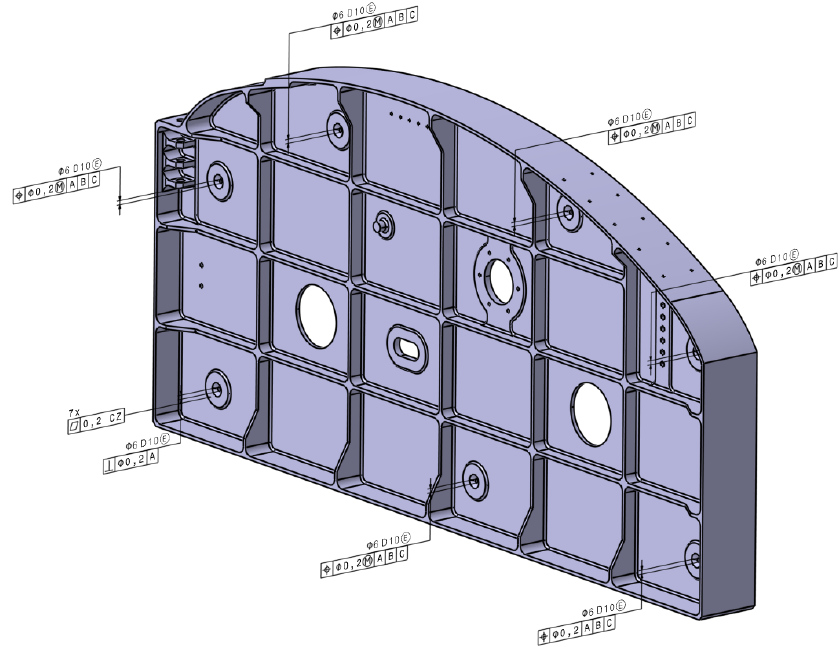
Figure A1. Tooling interface in ISO model.